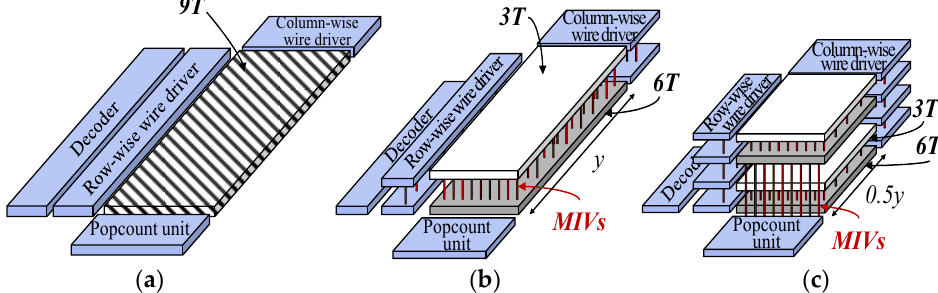
Figure 2. Three different CiM_SRAM designs. ( a ) CiM_SRAM (2D); ( b ) CiM_SRAM (M3D_2L); ( c ) CiM_SRAM (M3D_4L).